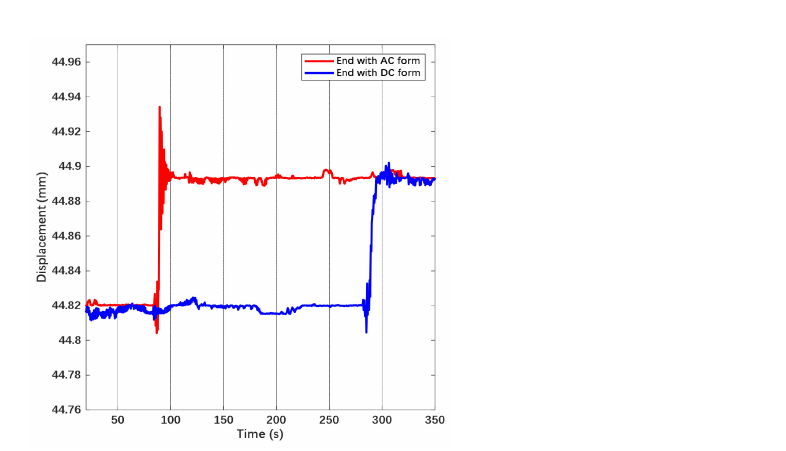
Figure 21. Displacement variation in time domain after switching off the